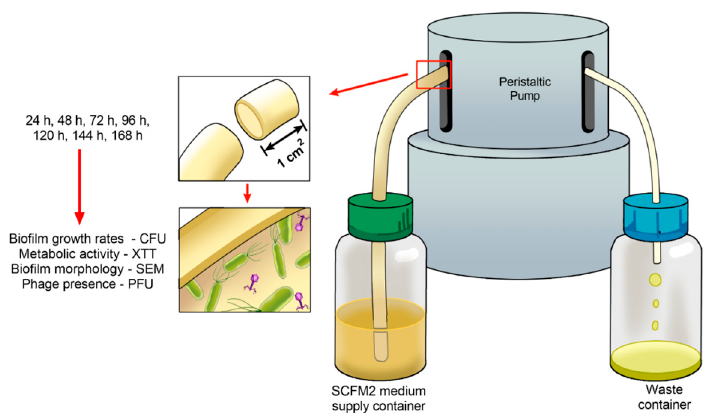
Figure 7. Schematic representation of the dynamic biofilm system showing that biofilm growth was monitored over 24 up to 168 h for colony forming units, metabolic activity, and biofilm morphology. Phage titer was also assessed during the entire cultivation time.